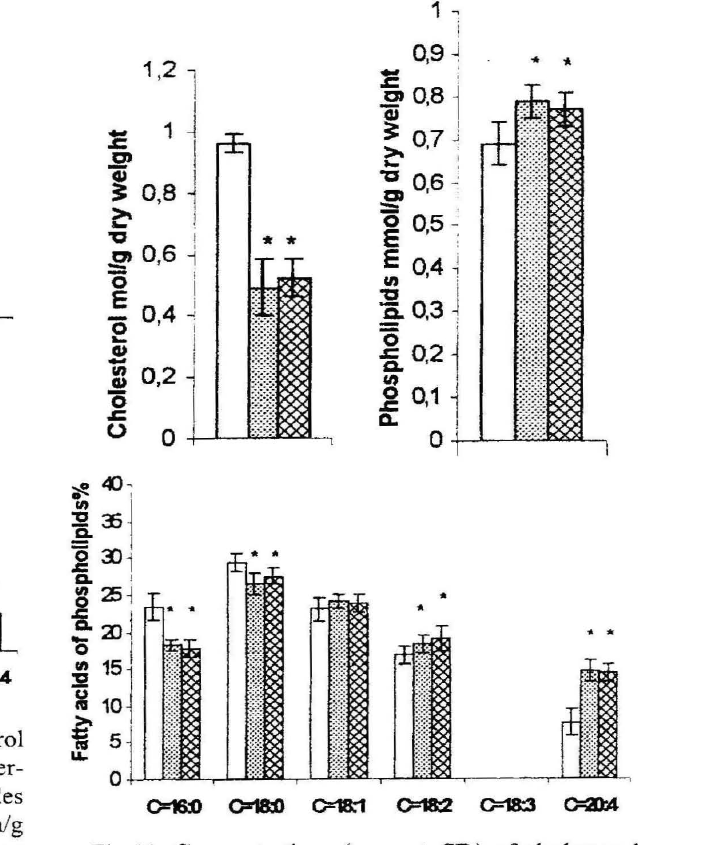
Fig.11. Concentrations (mean ± SD) of cholesterol and phospholipids, as well as fatty acid content in per cent (mean ± SD) of phospholipids in control samples